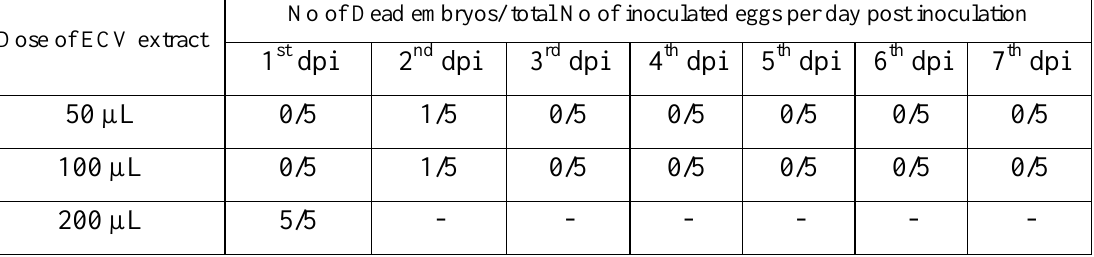
Table 3: Cytotoxicity effect of different concentrations of ECV extract on ECEs for seven days post- inoculation Dose of ECV